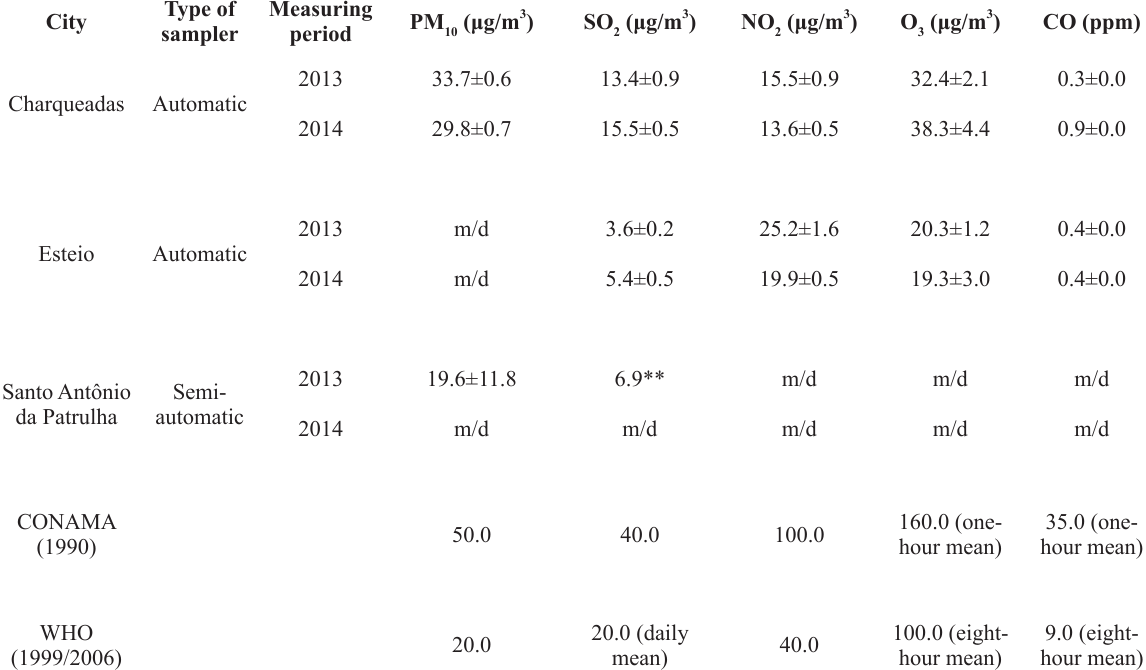
Means and standard deviations for PM sampled by the automatic and the semi-automatic air samplers in 2013 and